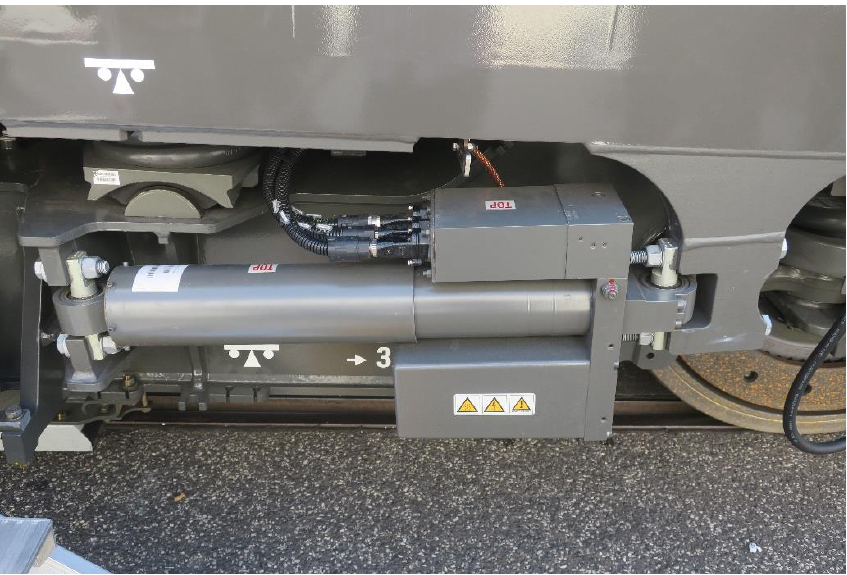
Figure 1. Active yaw damper on Siemens Vectron MS locomotive for Ö BB, Innotrans fair 2018.